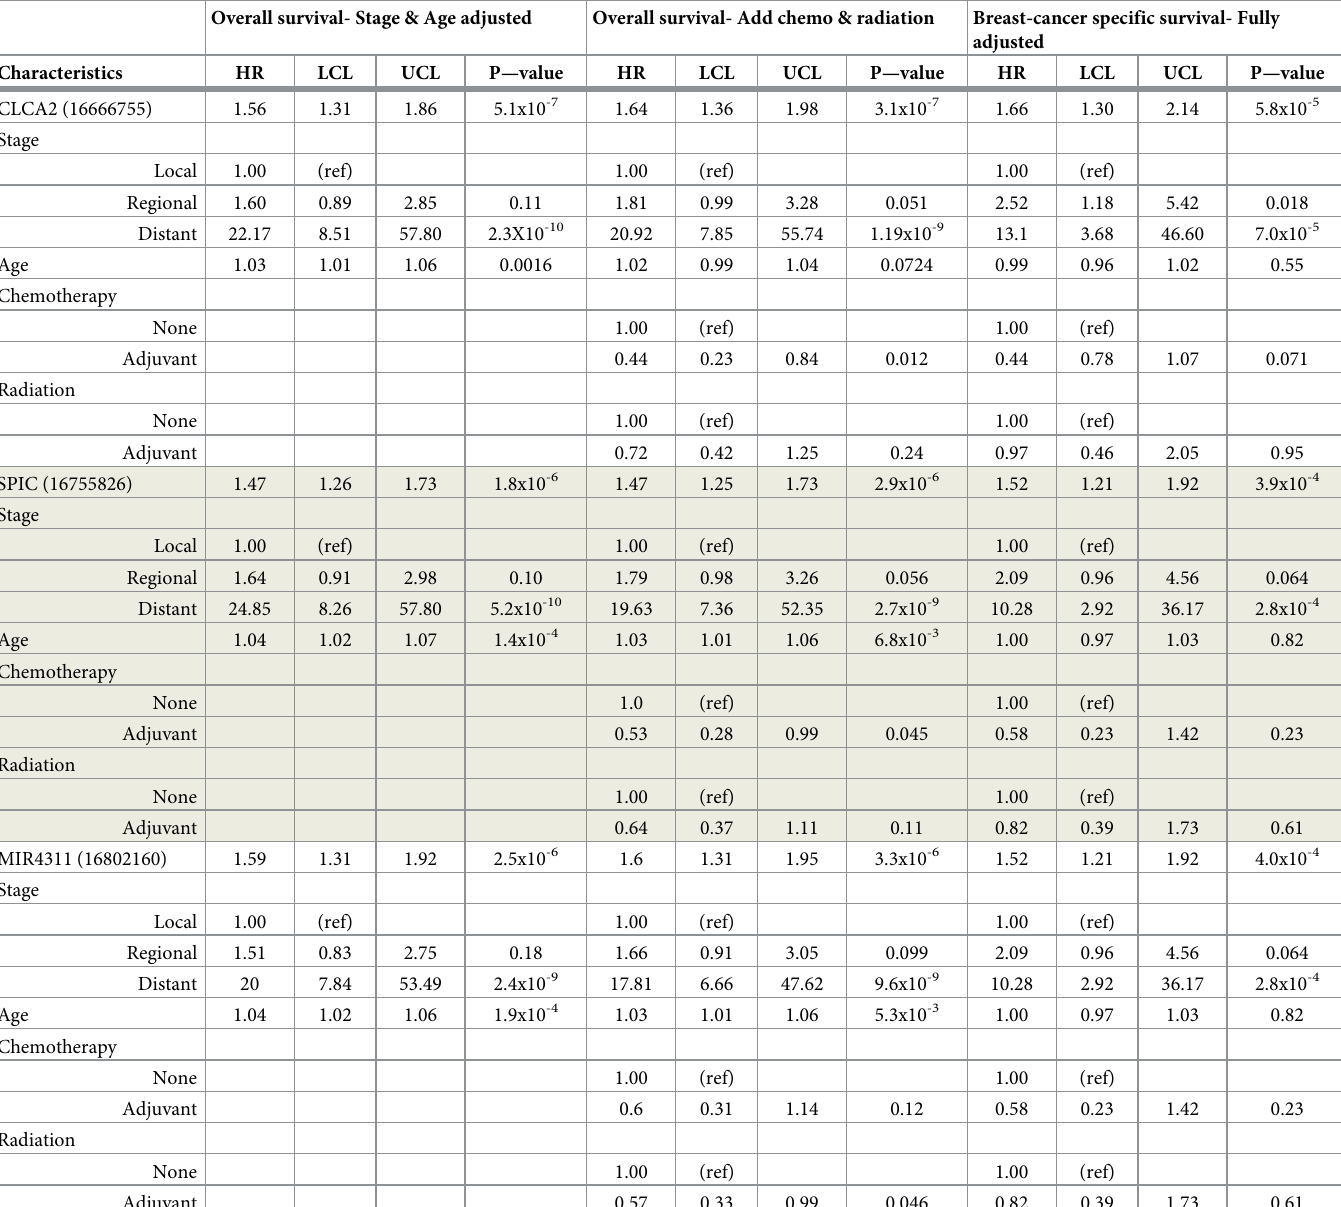
Table 2. Associations between CLCA2 , SPIC , and MIR4311 and overall and breast cancer specific survival in the Detroit AA cohort. Overall survival- Stage & Age